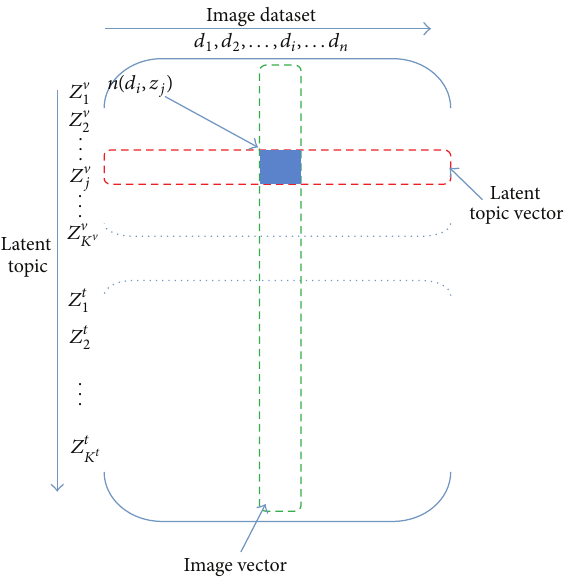
Figure 6: The cooccurrence matrix of image latent-topic.